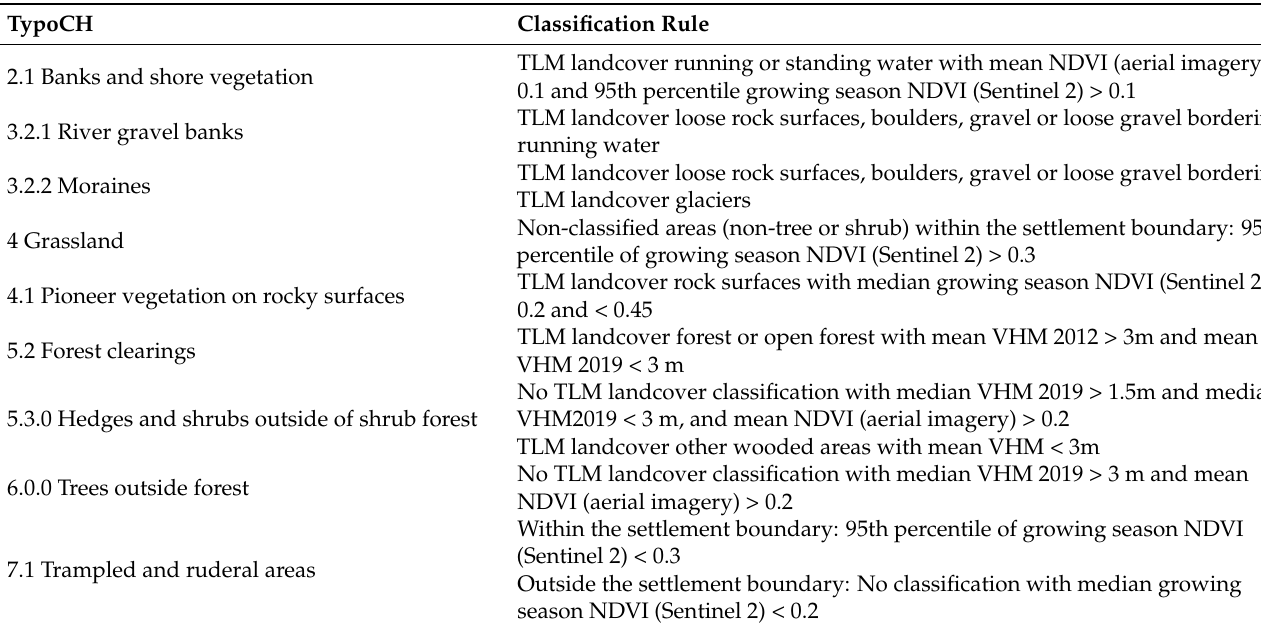
Table 3. Classification rules for habitats that are defined through a rule set. TypoCH Classification